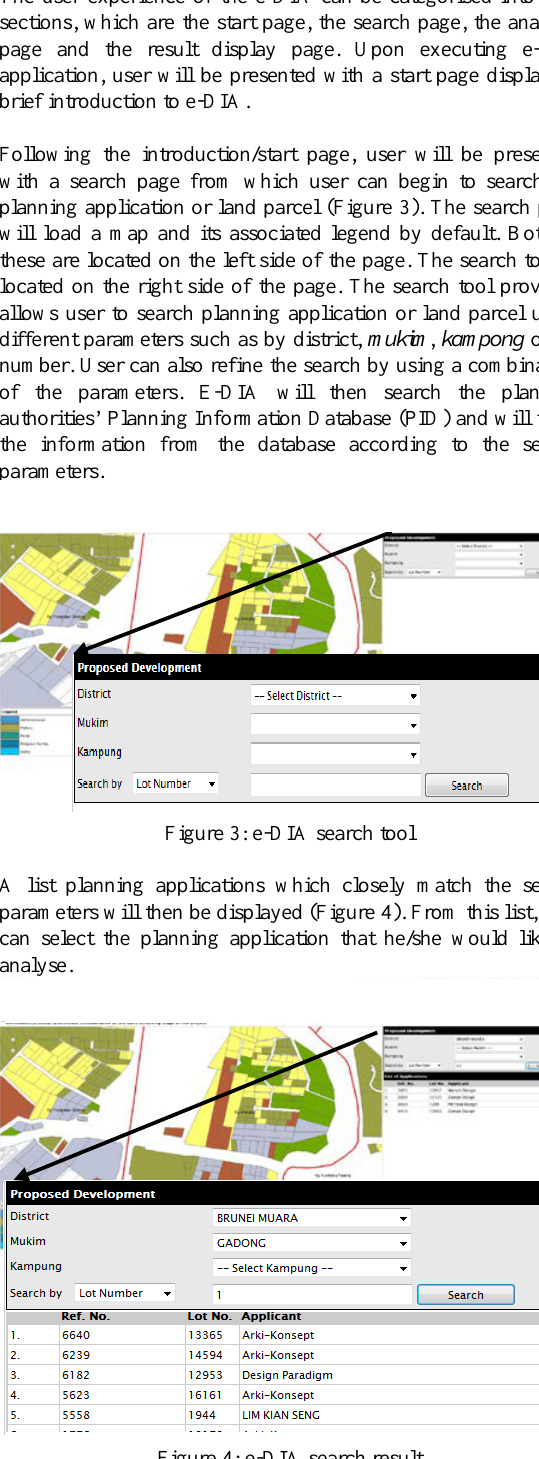
Figure 4: e-DIA search result